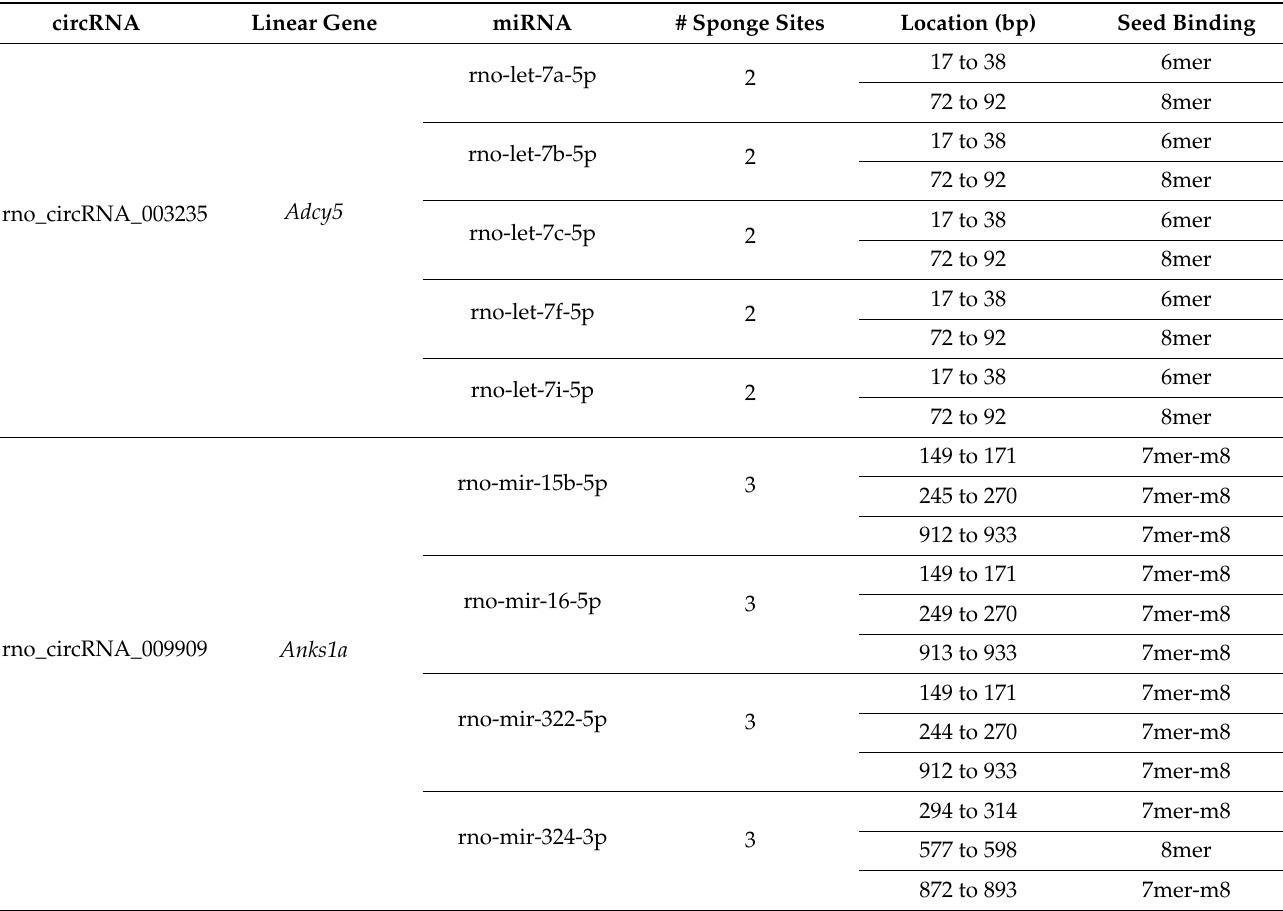
Table 1. microRNAs predicted to bind validated heroin-associated circRNAs. Shown are the locations of the top 5 predicted MRE sponge sites for each validated heroin-associated circRNA as well as the miRNAs predicted to bind at each MRE sponge site. Seed binding indicates the number of nucleotides (e.g., − 6mer = 6 nucleotides) in the miRNA seed sequence that are a match for the circRNA MRE sequence. The 7mer-m8 contains the best possible 7 nucleotide binding pattern, as it includes a seed match to the 8th nucleotide in the miRNA seed